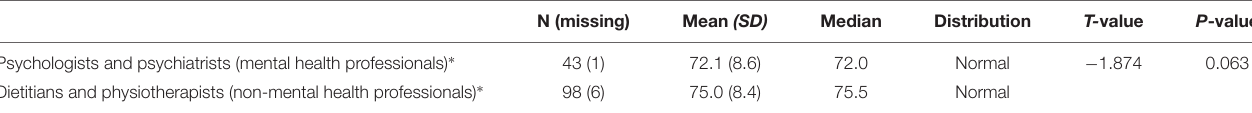
N (missing) Mean (SD) Median Distribution T- value P